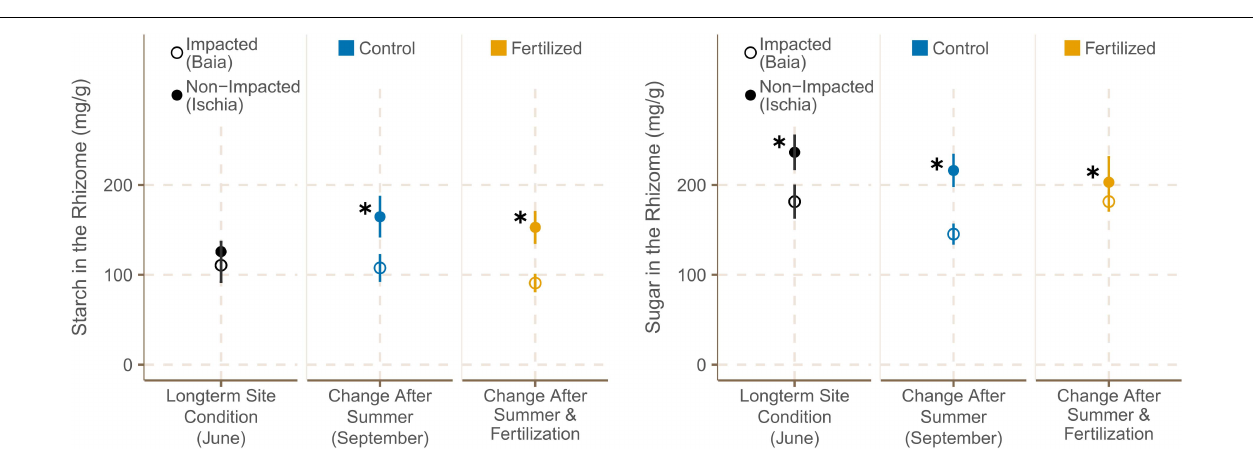
FIGURE 6 | Starch and sugar concentrations [mg g - 1 ] in rhizomes (mean ± SE) of P. oceanica plants ( n = 6) in fertilized and control plots from different sites in June and September 2019. (cid:81) Shows significant differences between impacted (Baia) and non- impacted (Ischia)